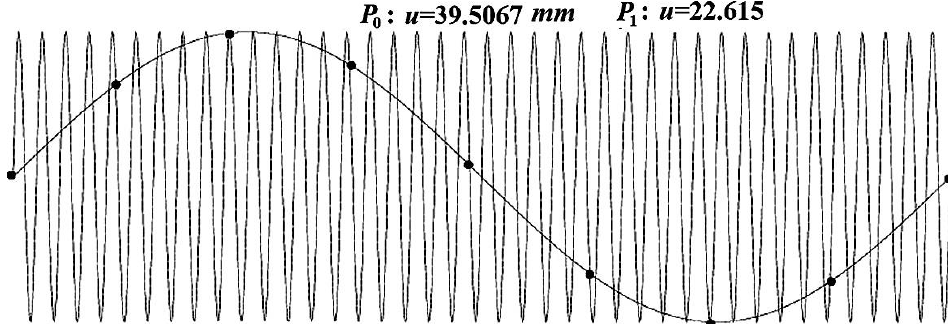
Figure 13. The capturing protocol under normal lighting conditions and using low-speed CCDs